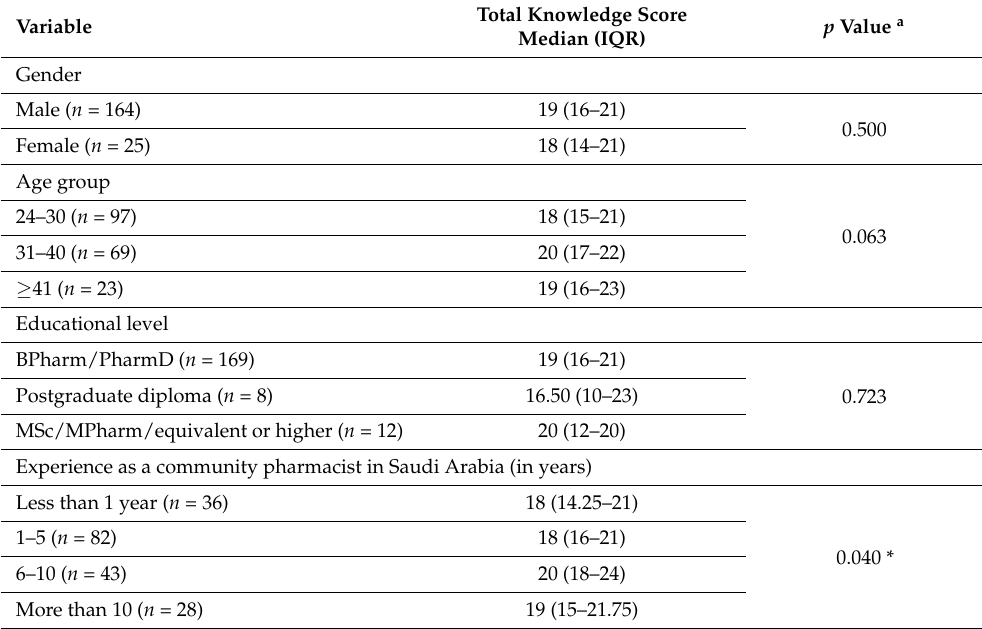
Table 4. The association between participants’ knowledge and their sociodemographic